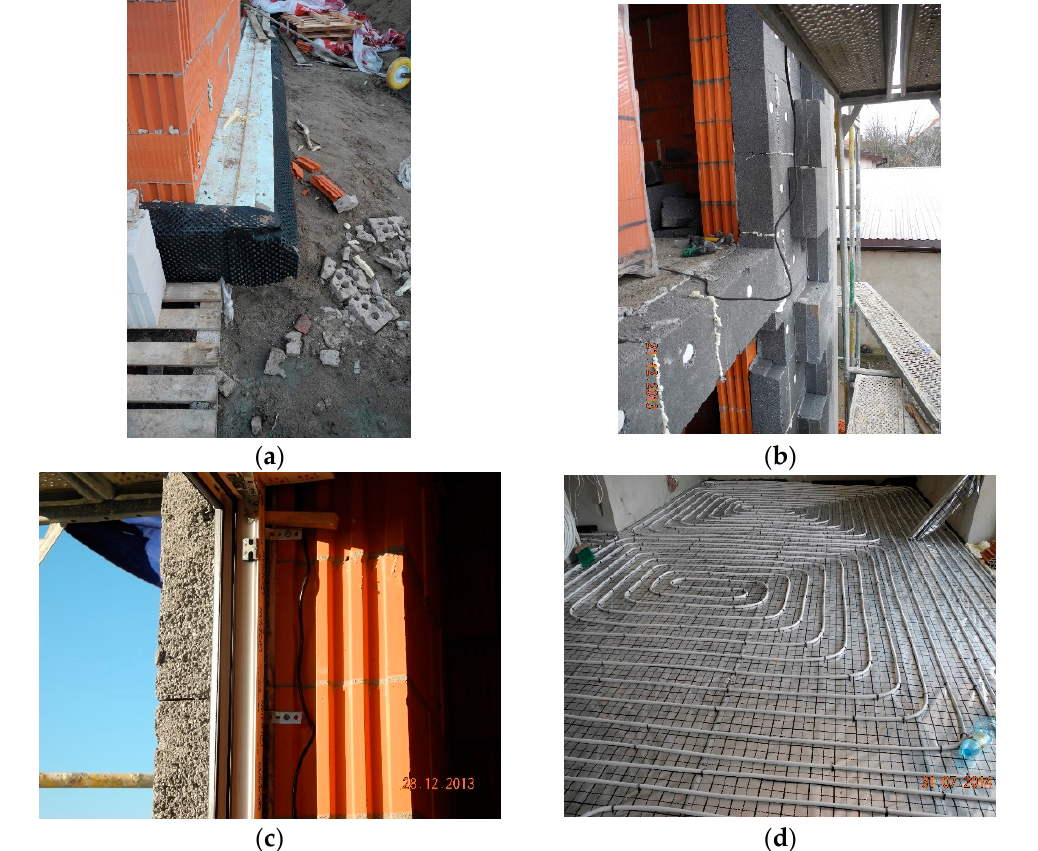
Figure 8. Photographs of the construction stage of the building: ( a ) Foundation wall insulation; ( b ) wall insulation; ( c ) installing the window; ( d ) underfloor heating installation. Table 2. Heat transfer coefficient ( U -value) requirements for the WT2021 and NF15 standards [119,123] and achieved for the analyzed building